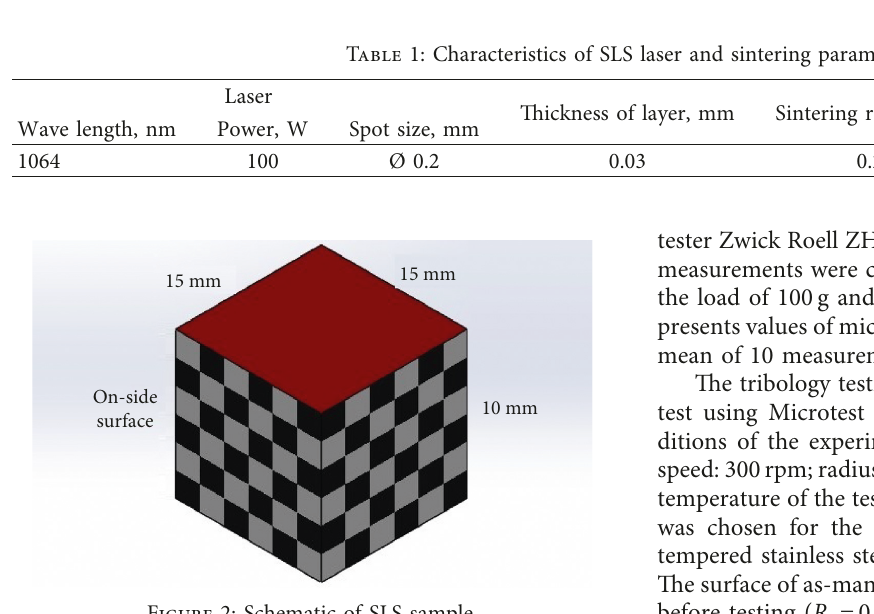
Figure 2: Schematic of SLS sample. Table 2: Coding of laser-processed samples. Sample